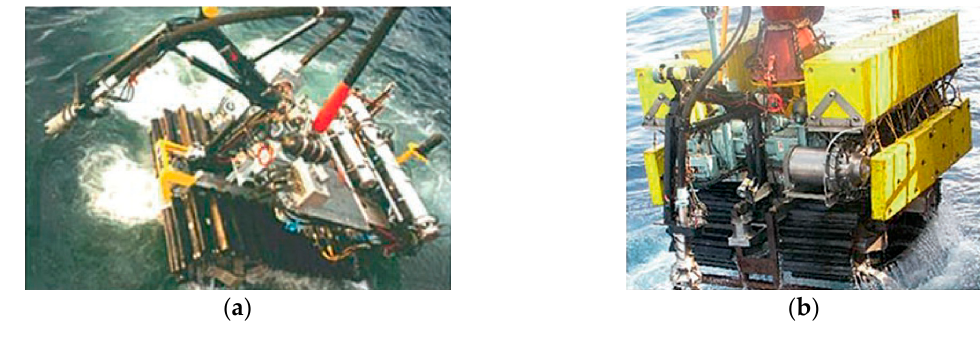
Figure 2. ( a ) Underwater mining system with manipulator and cutter for 500 m water depth; ( b ) Enhanced underwater mining system for 500 m water depth [33].